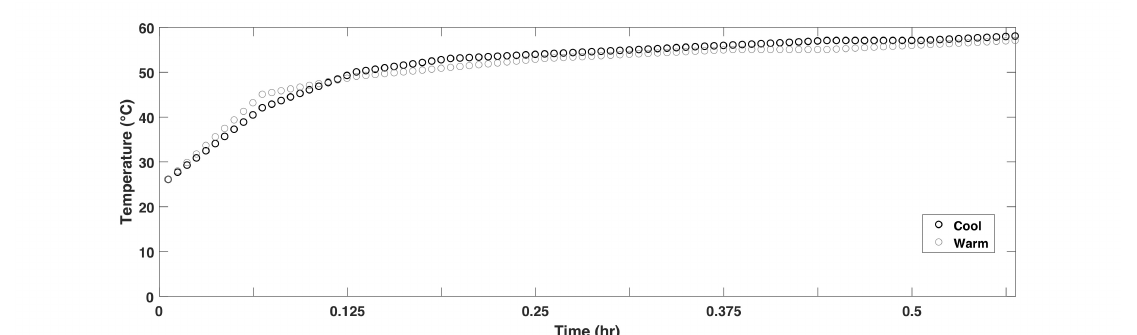
Figure 3. The mean values of the junction temperature of the cool channel (black) and warm channel (gray) of the LED light source increasing as a function of